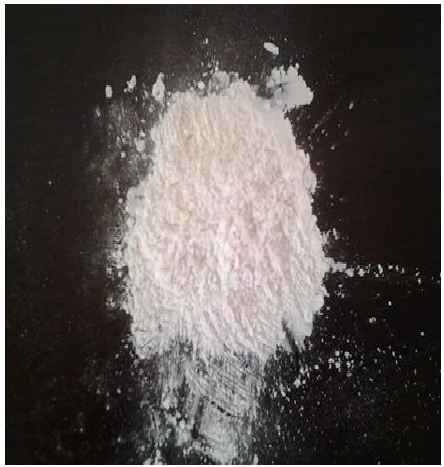
Figure 1. Photograph of native cassava starch.